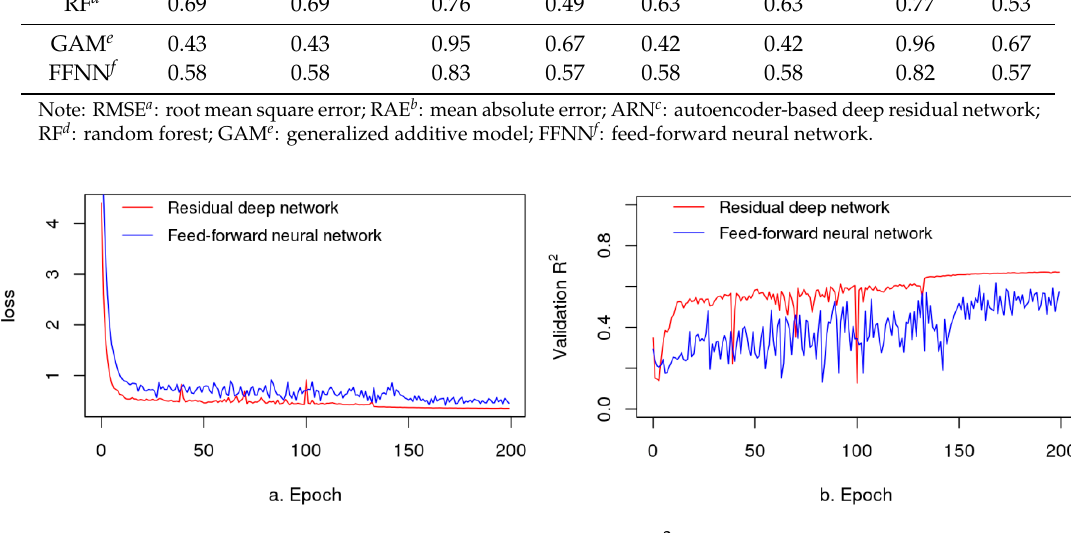
Figure 6. Learning curves ( a . validation loss; b . validation R 2 ) of deep residual network vs. feed- forward neural network.